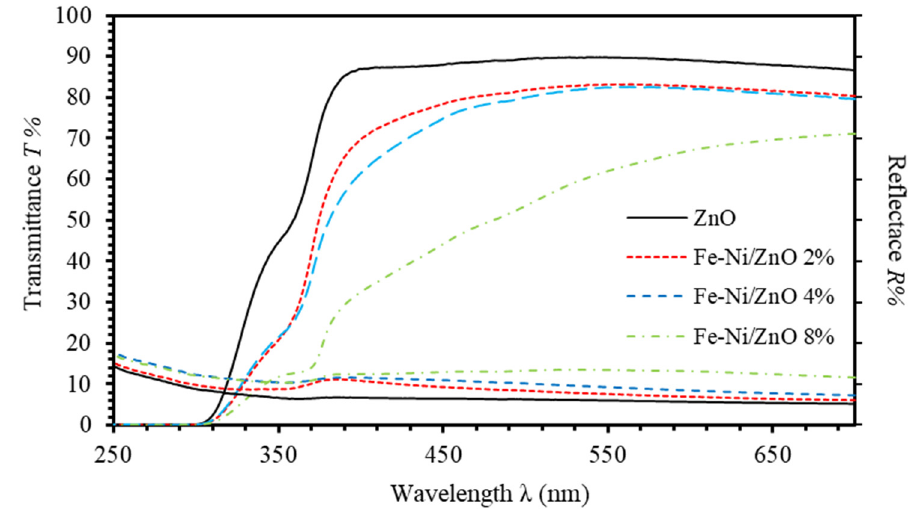
Figure 6. The transmittance and reflectance spectra of undoped ZnO and Fe-Ni co-doped ZnO thin films for various concentrations of Fe-Ni.